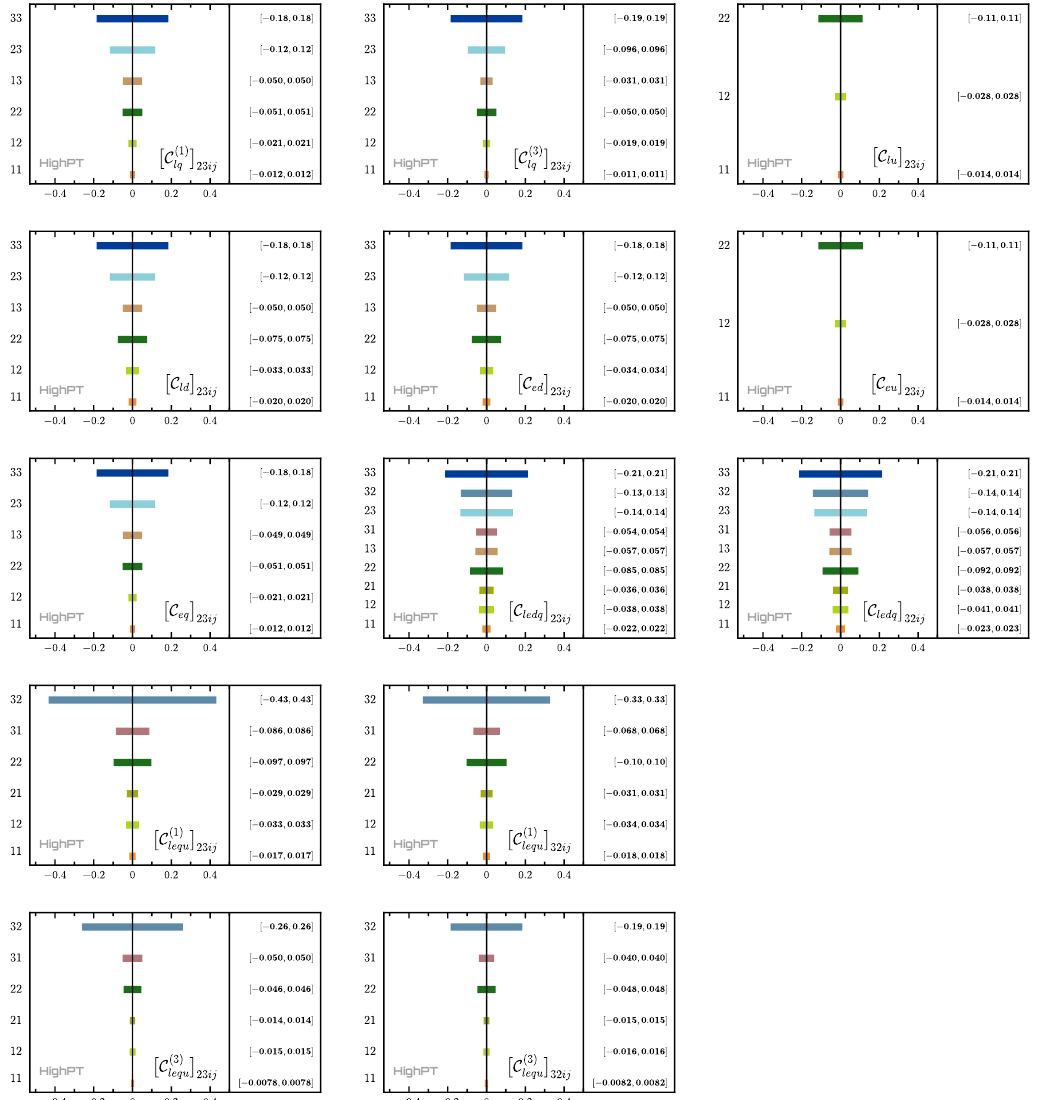
Figure 17. LHC constraints on ψ 4 semileptonic d = 6 Wilson coefficients with µτ flavor indices, where a single coefficient is turned on at a time. See caption of figure